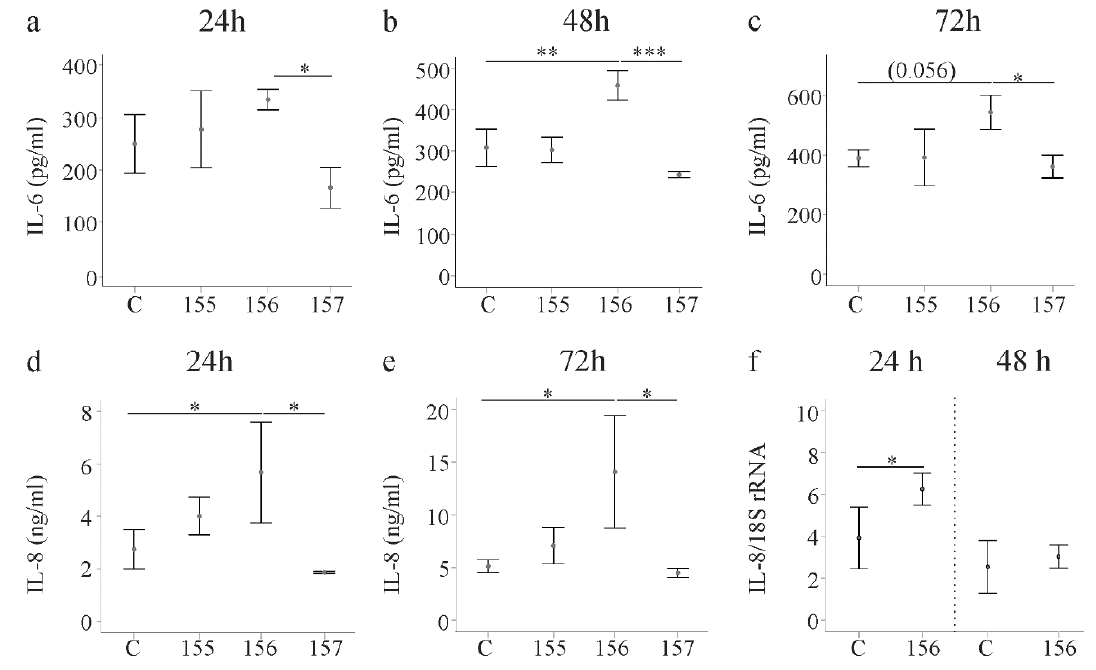
Figure 5. IL-6 and IL-8 in media of LX-2 cells expressing chemerin isoforms. ( a – c ) LX-2 cells were transfected with an insertless plasmid (C) and plasmids to express huChem-155, 156 and 157. IL-6 was analyzed by ELISA at 24, 48 and 72 h post-transfection; ( d , e ) LX-2 cells were transfected with an insertless plasmid (C) and plasmids to express huChem-155, 156 and 157. IL-8 was analyzed by ELISA at 24 and 72 h post-transfection; ( f ) IL-8 mRNA in these cells at 24 and 48 h post-transfection. * p < 0.05, ** p < 0.01, *** p < 0.001the number in c in the bracket is the p -value. N = 3 for all data shown.